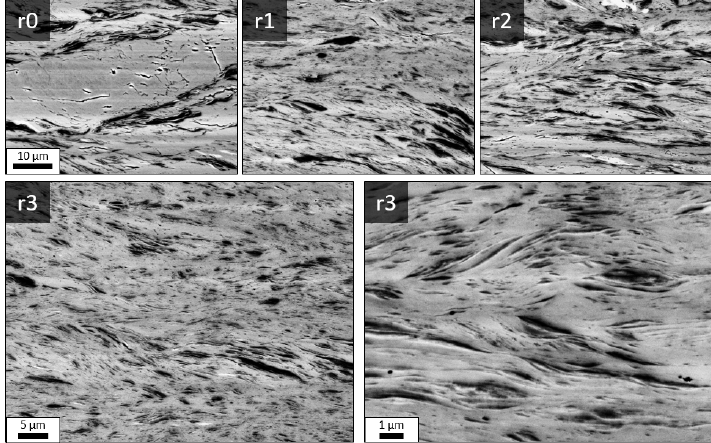
Figure A1. BSE images of a HPT-deformed sample (Nr. 1) at RT consisting of 10 wt.% Fe–90 wt.% SmCo 5 at different radii. The scale bar in r0 also applies to r1 and r2. Images of two magnifications are presented for